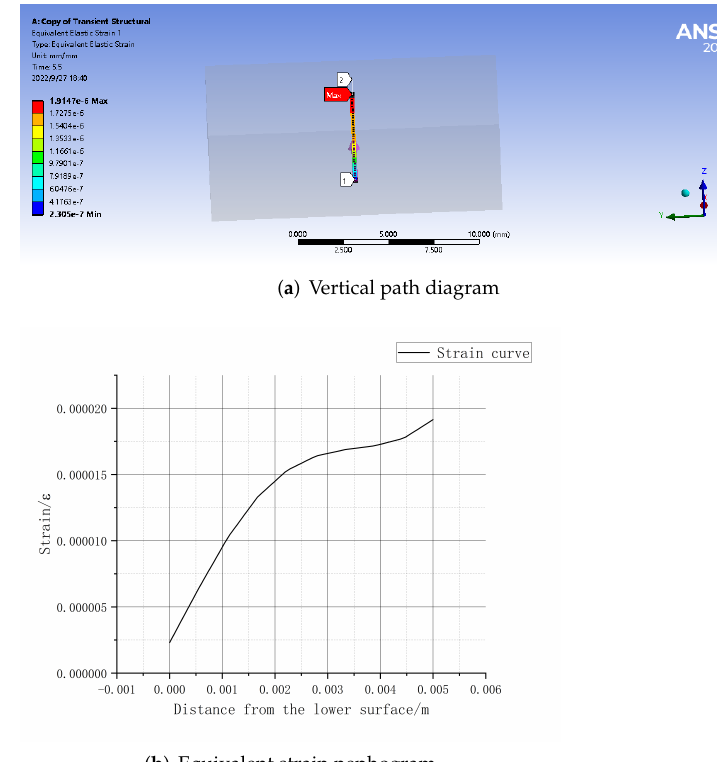
Figure 12. Axial path strain